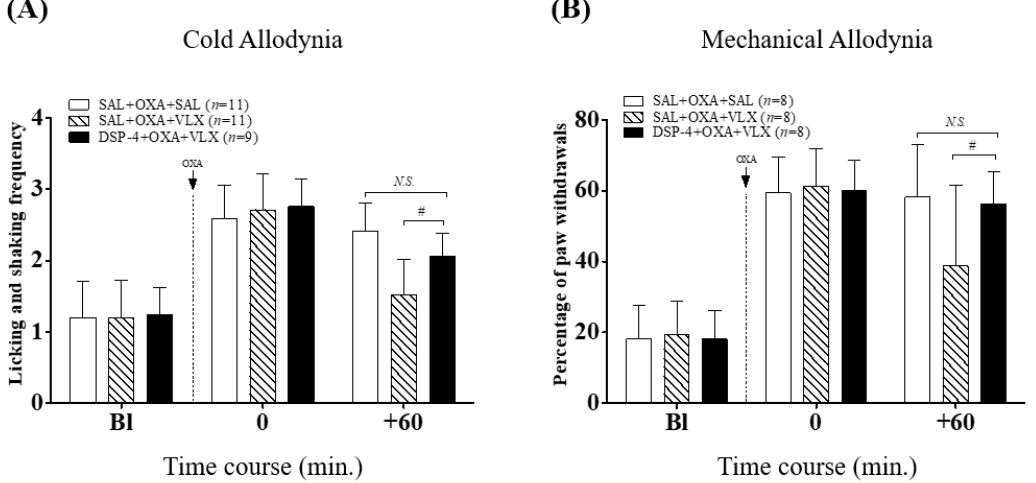
Figure 3. Roles of noradrenaline on the relieving effects of VLX on oxaliplatin-induced cold ( A ) and mechanical ( B ) allodynia in mice. Oxaliplatin (OXA, 6 mg/kg, i.p., dotted line) was injected one day after the DSP-4 (50 mg/kg, i.p.) or saline (SAL, vehicle) treatment. On day four, mice were subjected to the measurements just before the VLX (VLX, 40 mg/kg, i.p.) or saline (SAL) injection and 60 min after the treatments. “Bl”, baseline; # p < 0.05, vs. SAL + OXA + VLX; N.S. , no significance ( p > 0.05), vs.